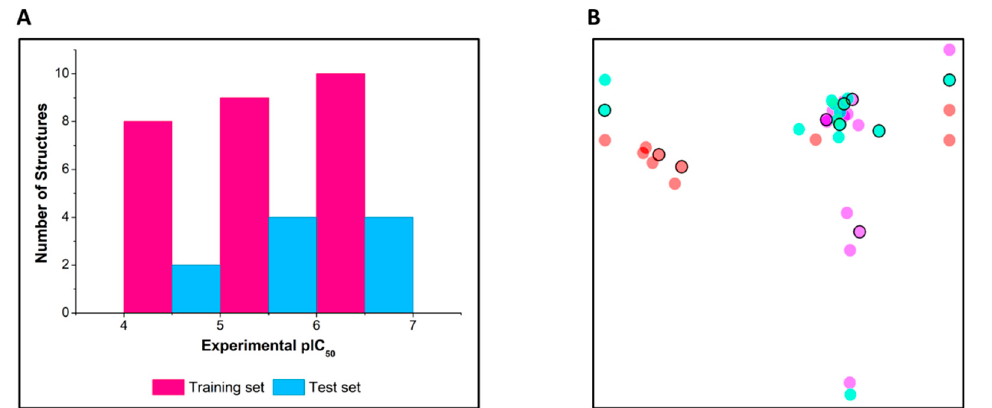
Figure 1. ( A ) Distribution of the dataset into training and test sets according to pIC 50 ranges. ( B ) Structural similarity map. The encircled points represent test set compounds. Structural similarity is inversely proportional to the distance between the points, and the colors represent pIC 50 intervals. Red: 4.00–5.06; cyan: 5.07–6.12; and magenta: 6.13–6.92.